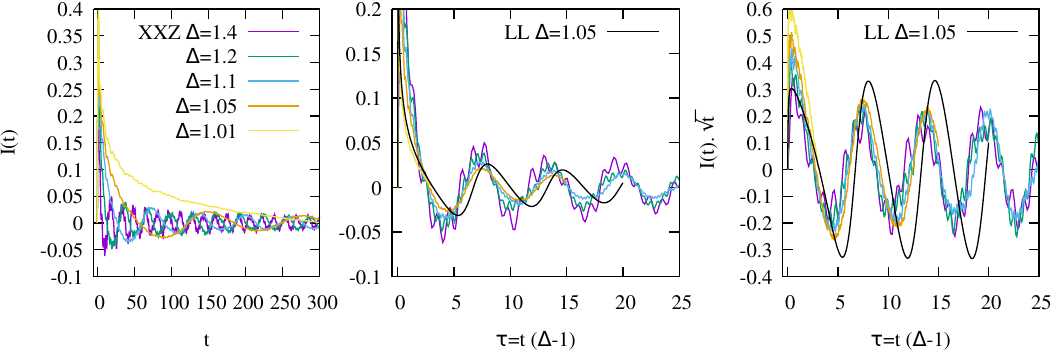
Figure 8: Left panel: Current I ( t ) for different values of ∆ , from 1.01 to 1.4, in the XXZ chain. Data obtained from tDMRG simulations on a chain with L = 600 or 800 sites and maximum bond dimension between 1000 and 2000. Middle panel: same data plotted as a function of τ = ( ∆ − 1 ) t . The relatively good collapse of the curves associated to different values of the anisotropy can be understood in the framework of the easy-axis LL model, thanks to the rescaling defined in Eqs. (9) which absorbs | δ | t . For the anisotropy δ = 2 ( ∆ − 1 ) into a definition of a new time variable τ = 1 2 comparison, the current obtained from the LL equation at ∆ = 1.05 is also shown (cid:112) t , which gives oscillations with (black line). Right panel: same data multiplied by an approximately constant